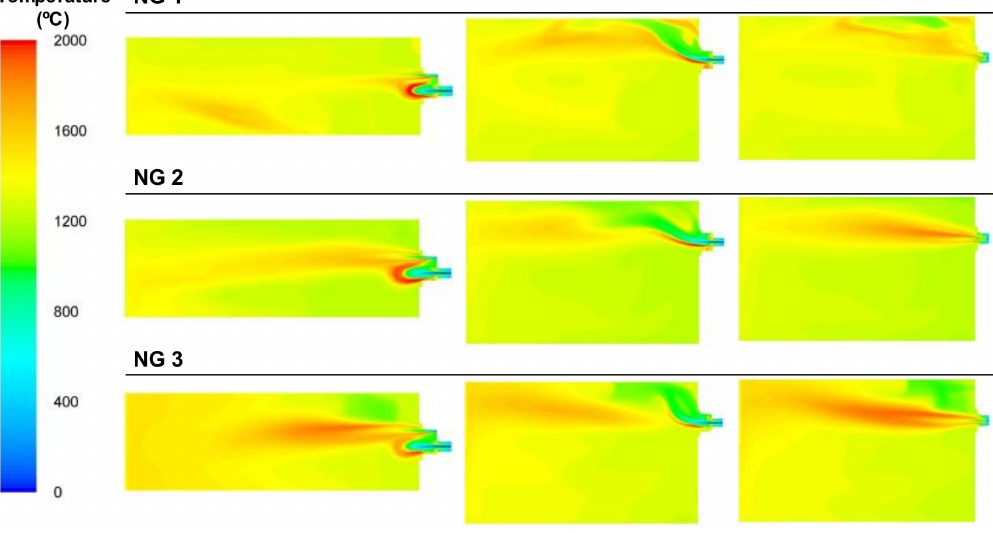
instead of reacting with the NG in the burner zone. Unlike the BFG and mixture cases, for NG, the contours of the maximum OH concentrations corresponded to the flame